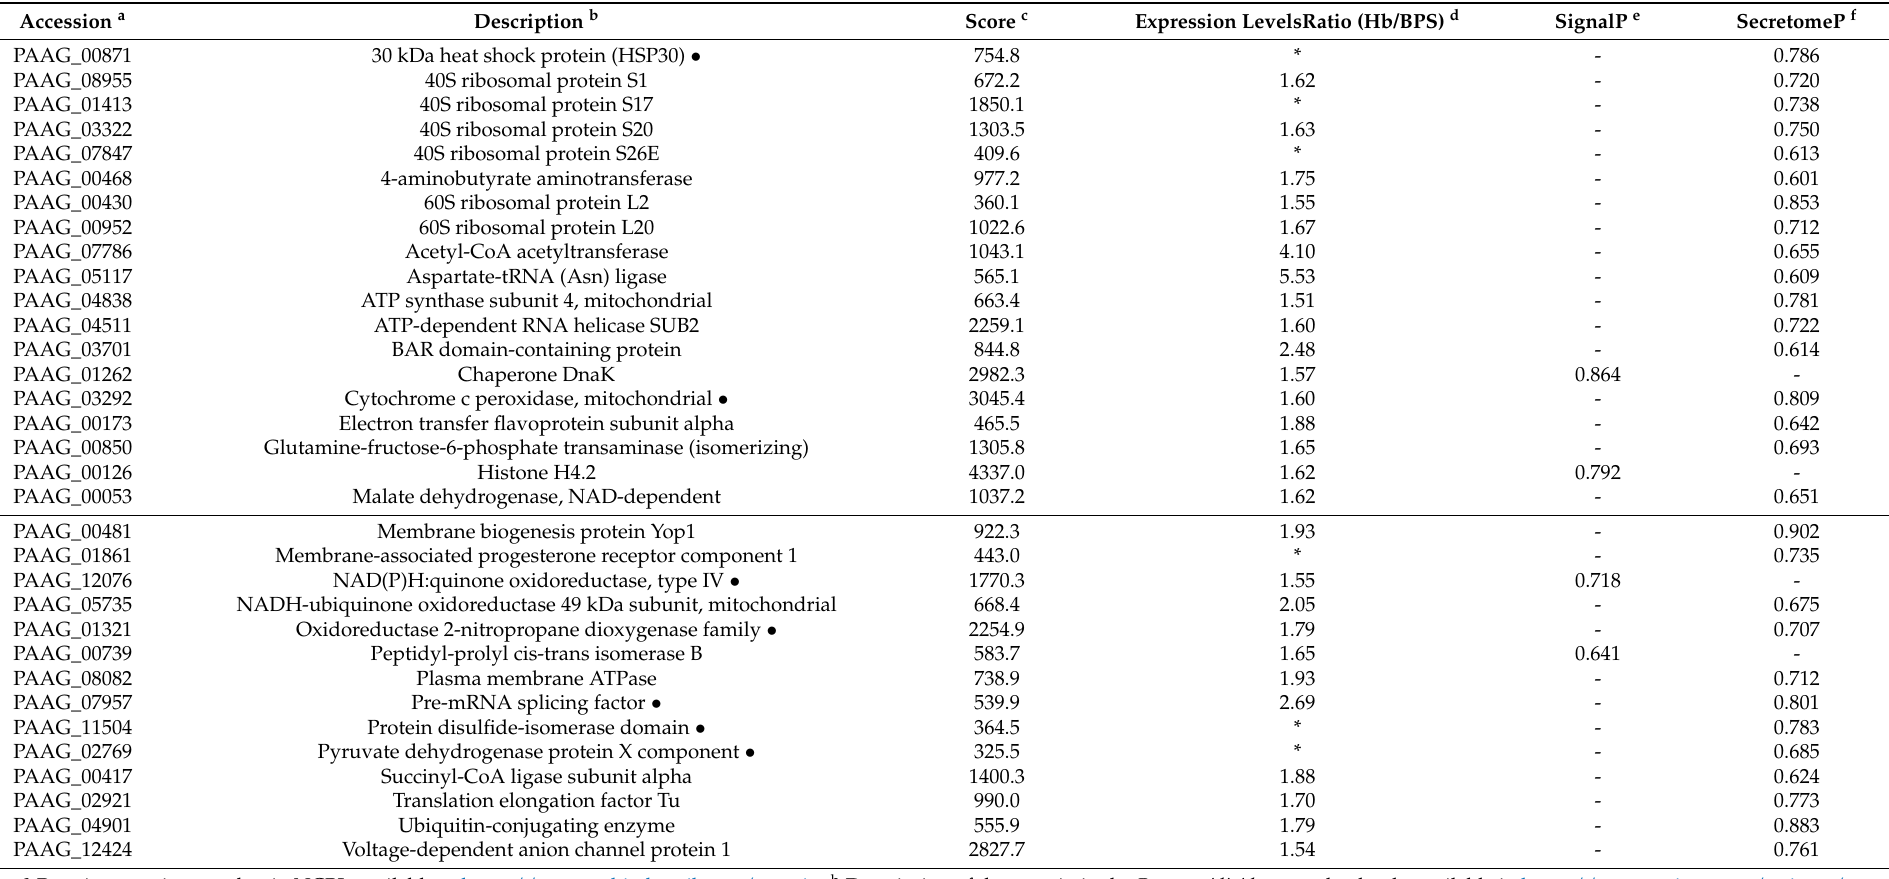
Table 1. Up-regulated proteins in Fraction 1 (F1) of the cell wall predicted as secreted, following Paracoccidioides lutzii yeast cells exposition to hemoglobin and bathophenanthrolinedisulfonic acid (BPS) for 48